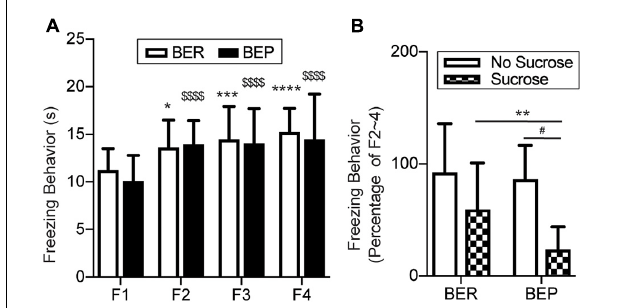
FIGURE 4 | Conditioned fear response in training sessions and the test session. (A) Freezing behavior during the Training sessions. *Significantly different ( p < 0.0.5) from the F1 session within the BER group. *** p < 0.001; **** p < 0.0001. $$$$ Significantly different ( p < 0.0001) from the F1 session within the BEP group. (B) Freezing behavior during the Training sessions normalized to the average freezing behavior of each animal during F2–4. F1–4, Fear Conditioning sessions 1–4. **Significantly ( p < 0.05) different from the BER-Sucrose group. # Significantly ( p < 0.01) different from the BEP-No Sucrose